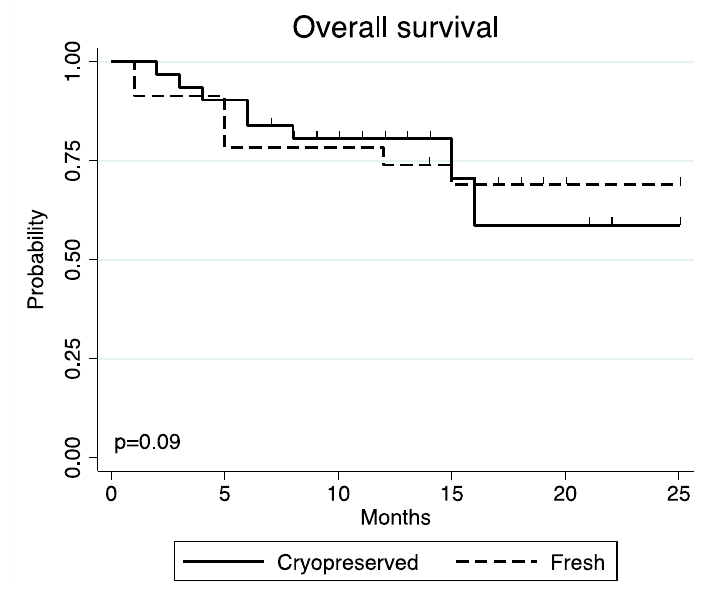
Figure 3. OS in patients receiving cryopreserved vs. fresh grafts.